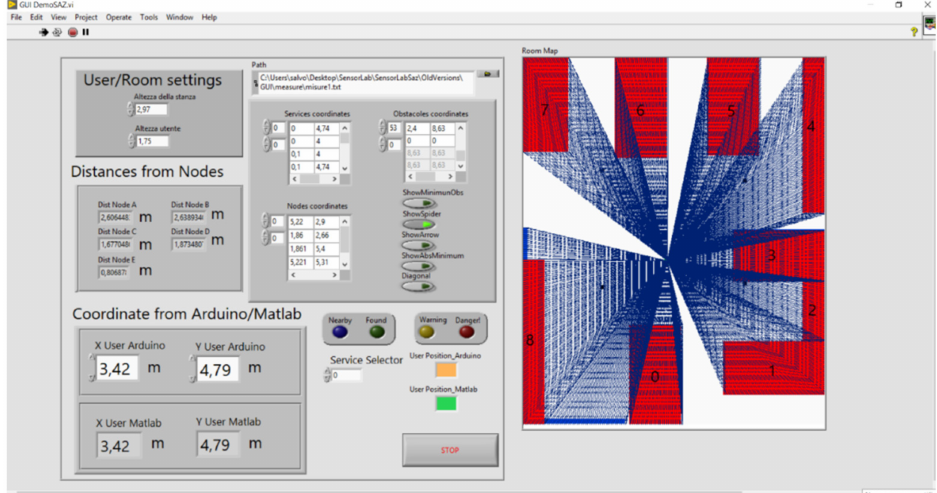
Figure 3. The overall user-object-nodes distance estimation functionality implemented in the Man- agement Tool.